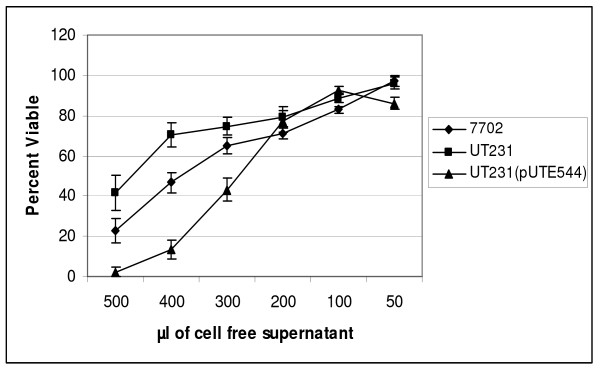
Cell free supernatants from B. anthracis secreting ALO lyse human monocyte derived macrophages significantly more than the ALO knockout strain, UT231, in a dose dependent manner. Percent viability of hMDMs from three different donors measured by trypan blue after the addition of filter sterilized B. anthracis supernatants in presence of heat-inactivated 10% FBS. The 3 h time point is shown, as little lysis was observed at earlier time points. Results are representative of results from three different experiments. (Dose, p < 0.001, strain, p < 0.001, dose by strain interaction, p = 0.044, as calculated by 2-way ANOVA. Tukey test showing significant differences between UT231/7702, UT231/UT231(pUTE544), 7702/UT231(pUTE544), p < 0.001)